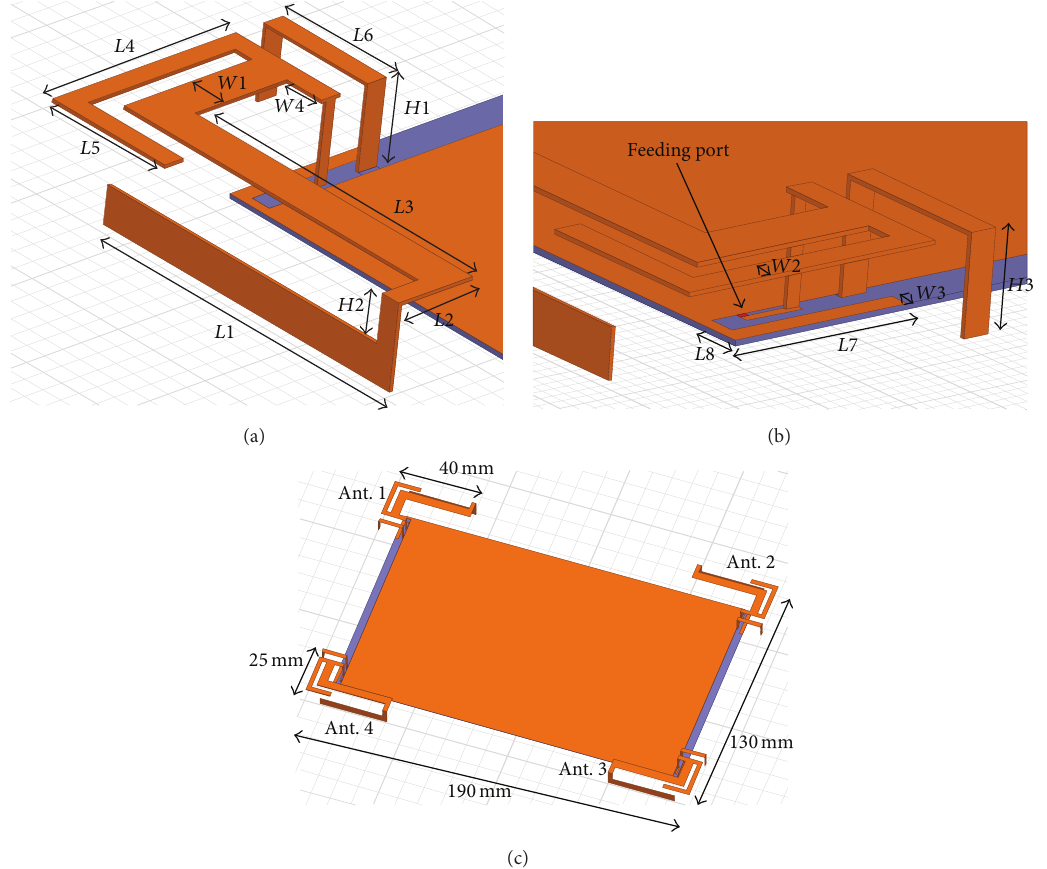
Figure 2: ((a) and (b)) 3D views of the single element and (c) view of the terminal integrating the 4 antenna elements.